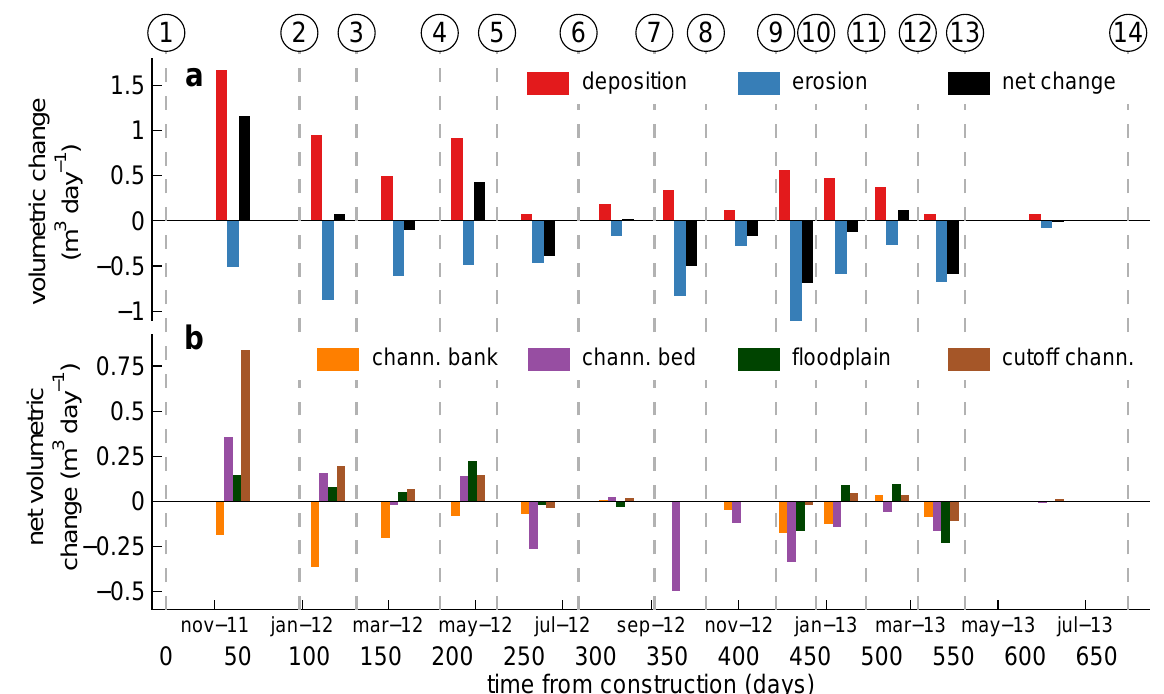
Figure 6. Temporal evolution of the volumetric change in sediment storage. (a) Volumetric change in sediment storage (m 3 day − 1 ) for regions of deposition (red), erosion (blue) and net change (black). (b) Volumetric change in sediment storage (m 3 day − 1 ), specified per geomorphic feature, with channel bank (orange), channel bed (purple), floodplain (green) and cutoff channel (brown). The dashed vertical lines indicate the surveying moments, and the numbers at the top of the figure correspond to the numbers in Table 1.